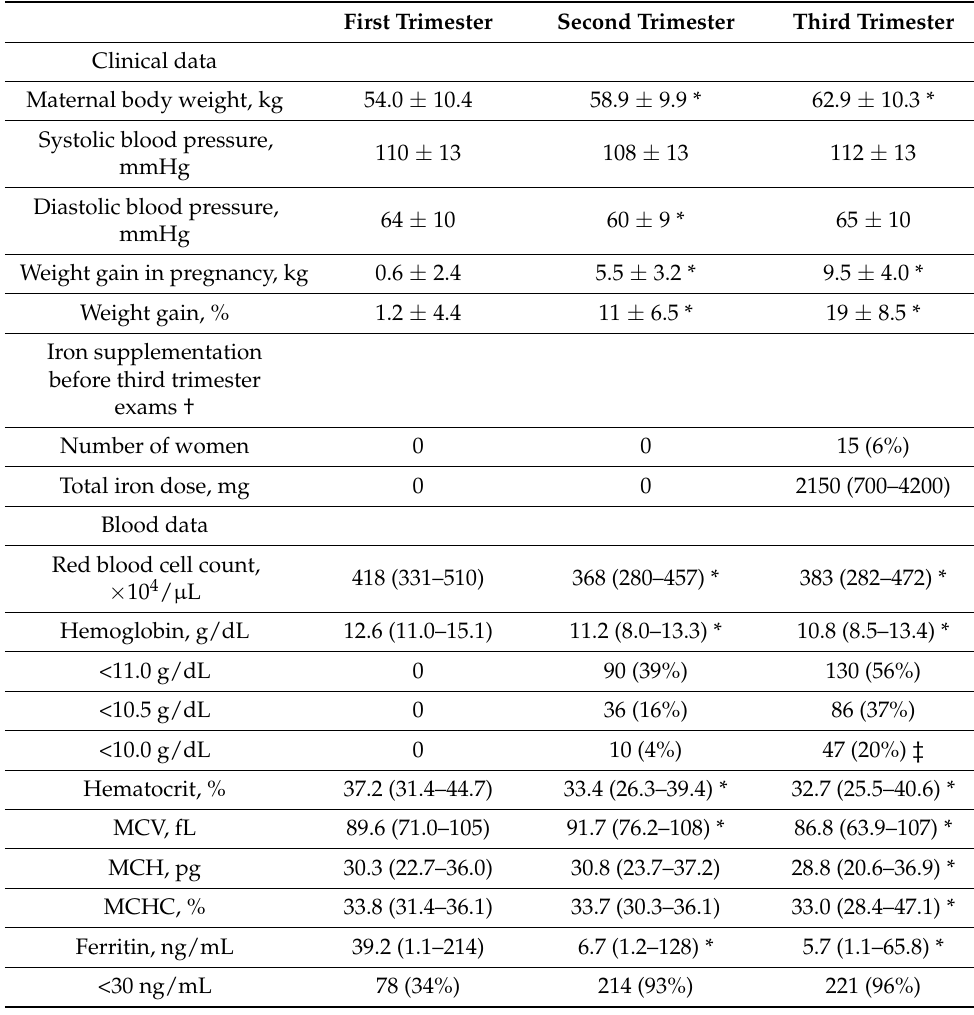
Table 2. Clinical data and blood parameters during